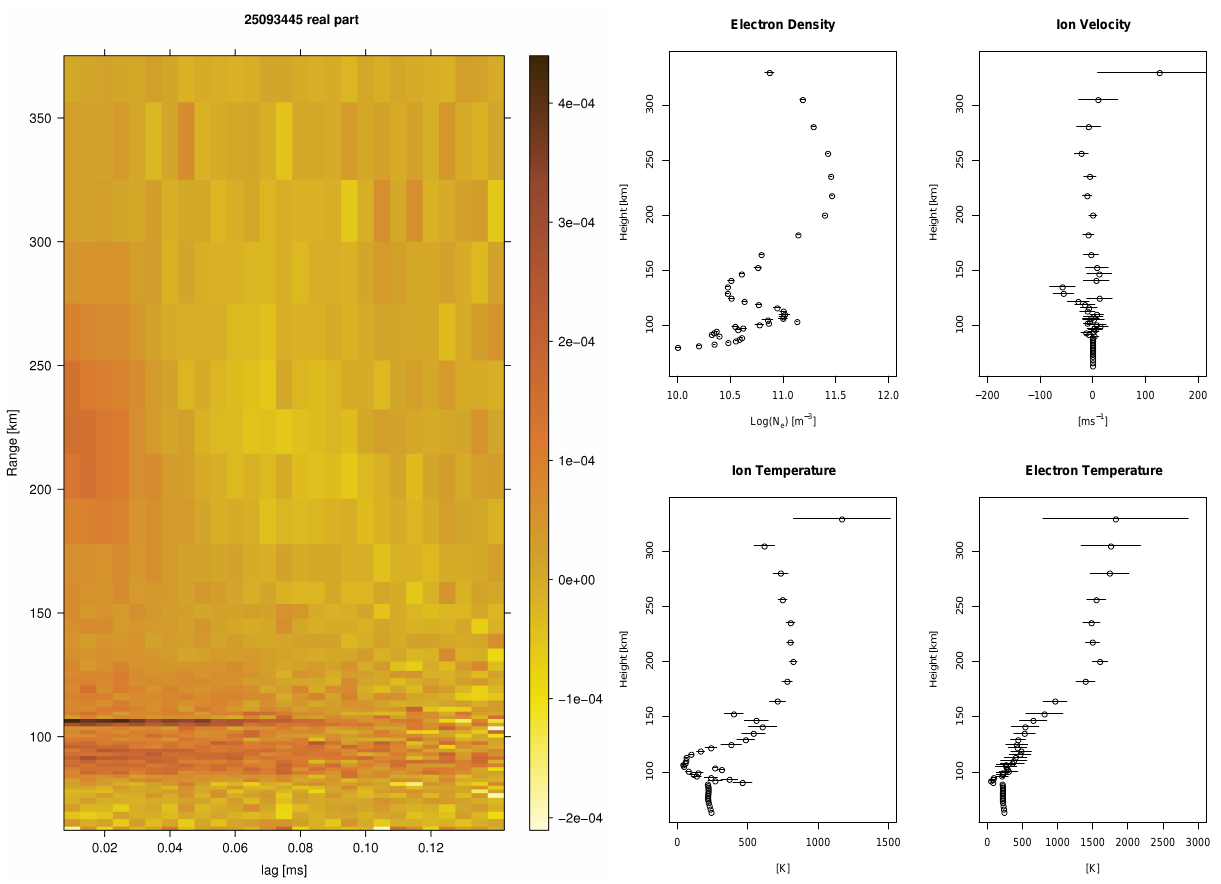
Fig. 6. Analysis results of experiment 1 from 18 October 2007 10:24UT. Left panel: Real part of ACF in arbitrary units. Time resolution is 5s and range resolution varies from 1.5km in D- and lower E-regions to 50km above F-region peak. Right panel: Plasma parameters with 1min integration time. The horisontal lines are 68% confidence intervals. Model values are used for ion mass and collision frequency at all altitudes, for ion temperature and electron to ion temperature ratio below 90km and ion velocity is set to zero below 90km. Electron density is not